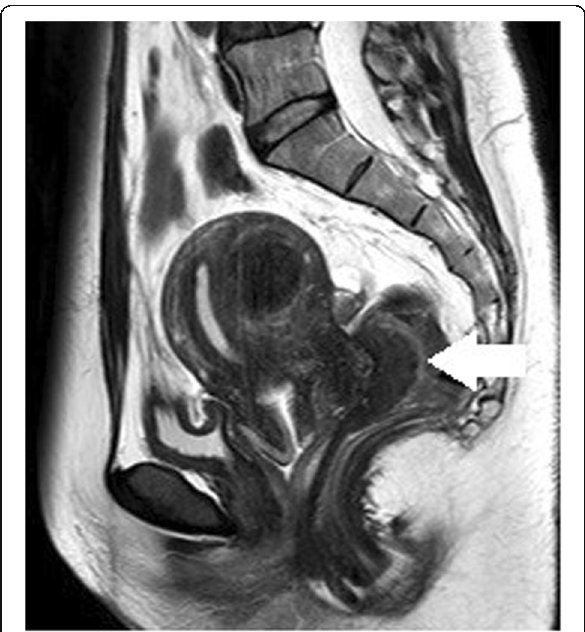
Fig. 5 Magnetic resonance imaging (MRI) shows a 40-mm mass on the anterior wall of the rectum